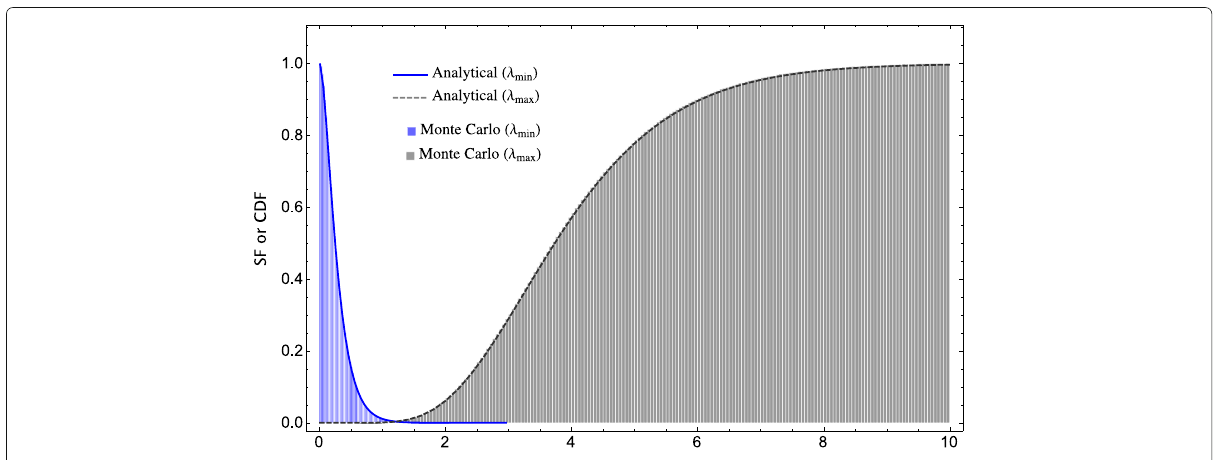
Fig. 3 SF of the smallest eigenvalue ( λ min ) and CDF of the largest eigenvalue ( λ max ), as given by (22) and (24). The parameter values are n = 3, n A = 4, n B = 5, and b = 1 / 3